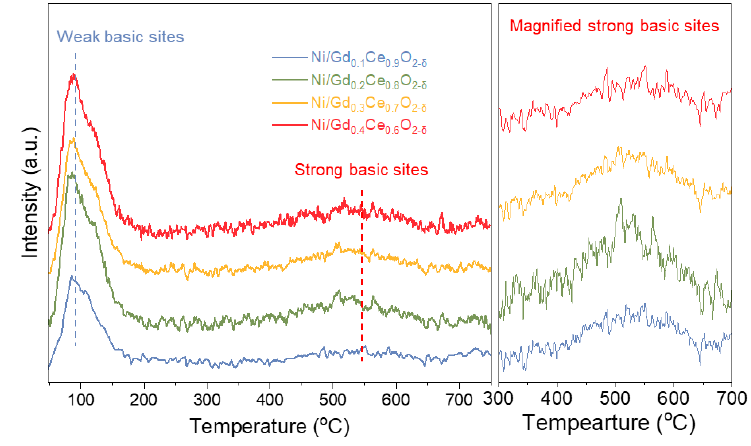
Figure 8. CO 2 -TPD profiles of the Ni/Gd x Ce 1-x O 2- δ catalysts.